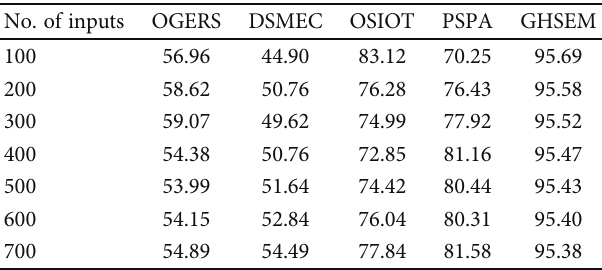
Table 5: Comparison of paint